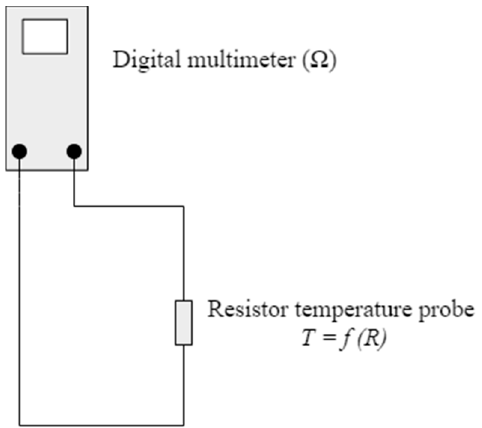
Figure 4. Resistance temperature device (RTD) showing calibrated resistor R and high impedance digital multimeter set to read ohms ( Ω ).